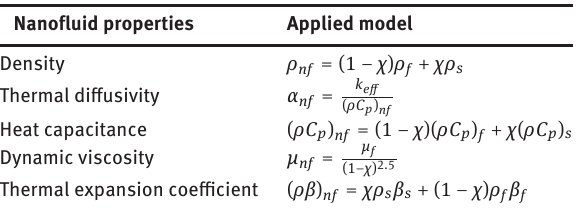
Table 2: Applied formulae for the nanofluid properties [25, 26, 29,